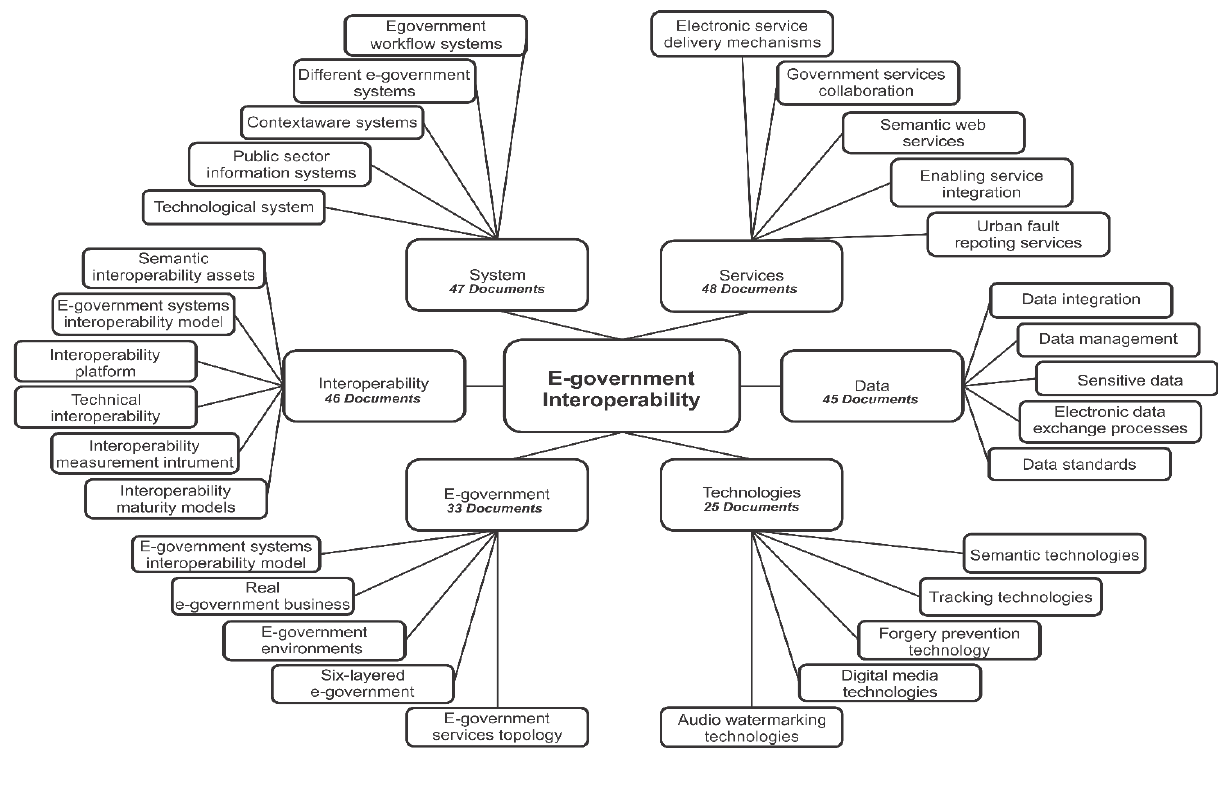
Figure 9: Mapping of the Theme of E-Government Interoperability Studies. Source: Processed by the m au-